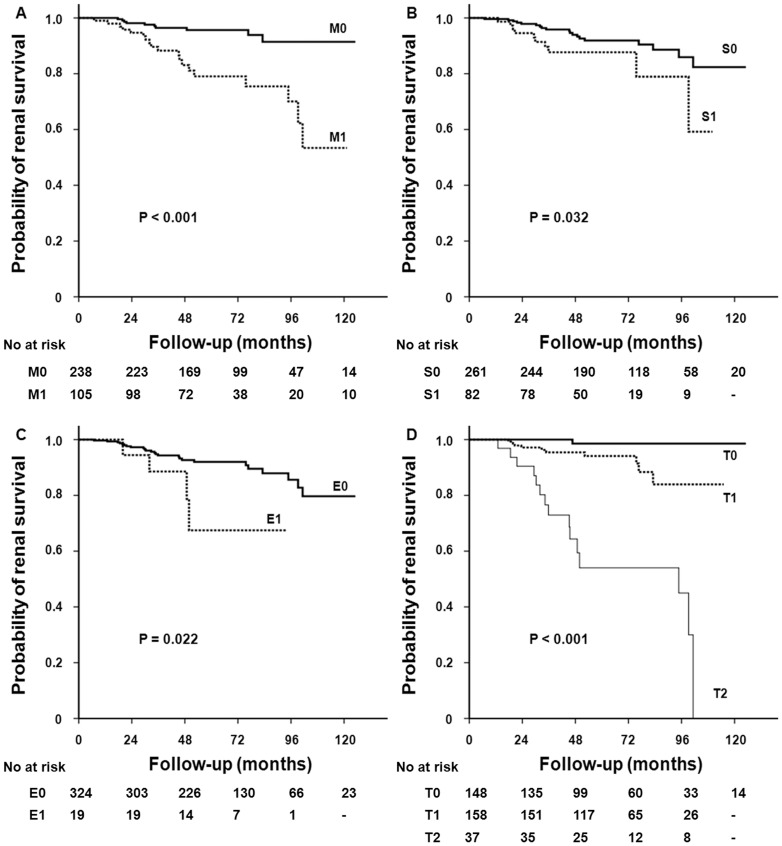
Kaplan-Meier analyses of cumulative renal survival of patients with IgA nephropathy according to histopathologic features including (A) mesangial hypercellularity, (B) segmental glomerulosclerosis, (C) endocapillary hypercellularity, and (D) tubular atrophy/interstitial fibrosis.Patients with mesangial hypercellularity, segmental glomerulosclerosis, endocapillary hypercellularity, and tubular atrophy/interstitial fibrosis had significantly lower renal survival than those without such findings (P<0.05).